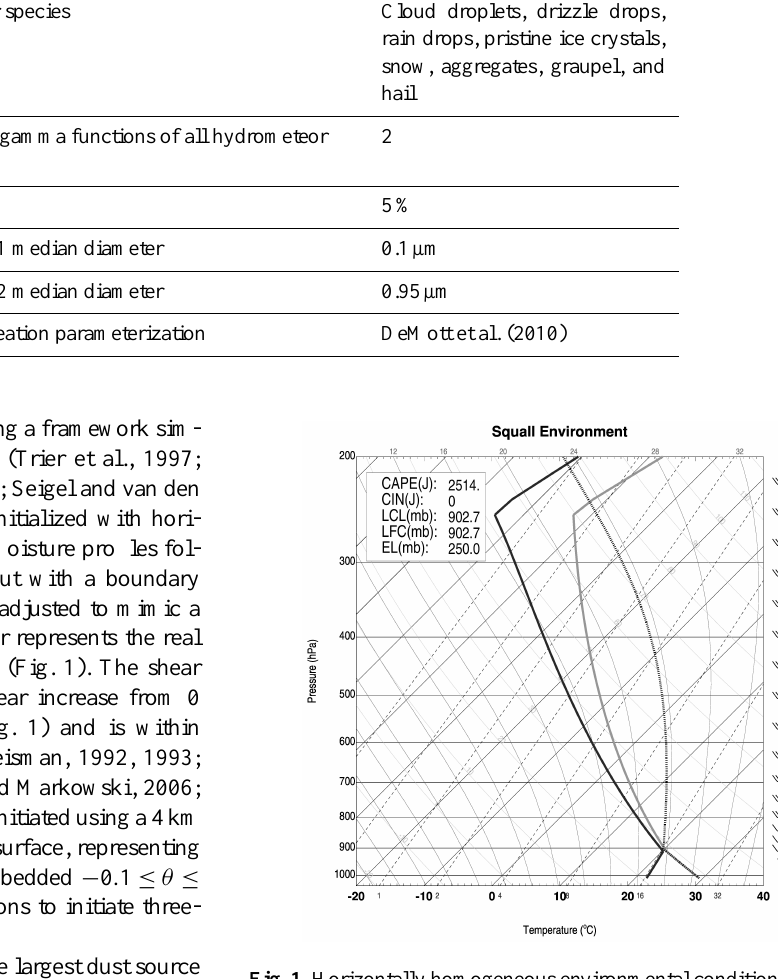
Table 1. Overview of microphysical parameterizations and parameters used in all simulations. Attribute Value Prognosed hydrometeor species Cloud droplets, drizzle drops, Shape parameter, ν , for gamma functions of all hydrometeor